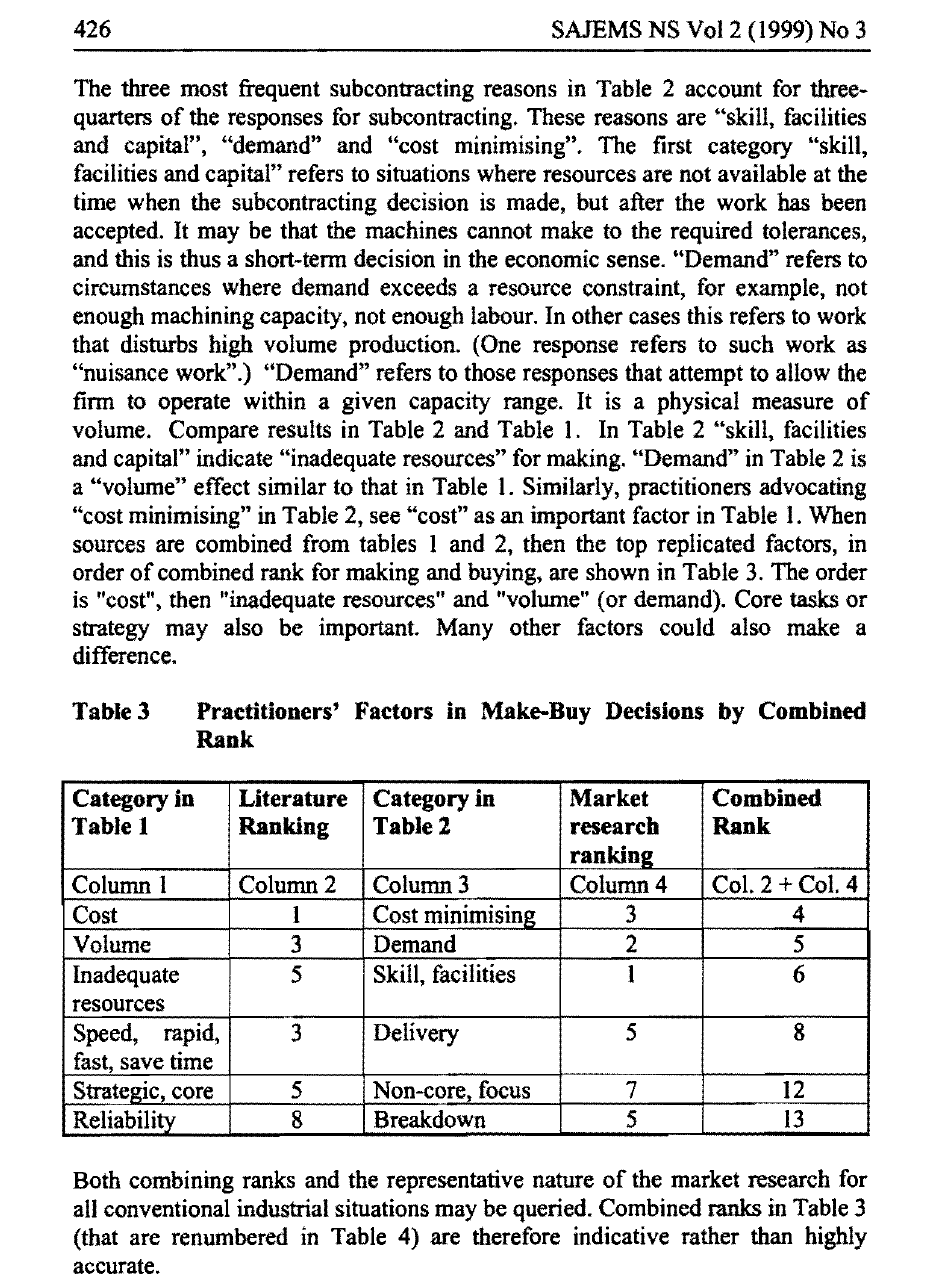
Practitioners' Factors in Make-Buy Deeisions by Combined Rank Category in Literature Category in Market Combined Ranking research Rank